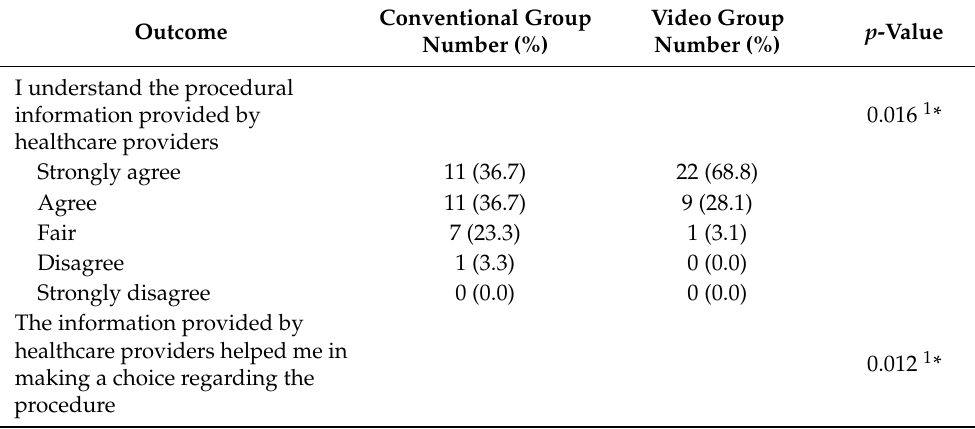
Table 4. Comparison of satisfaction between conventional and video